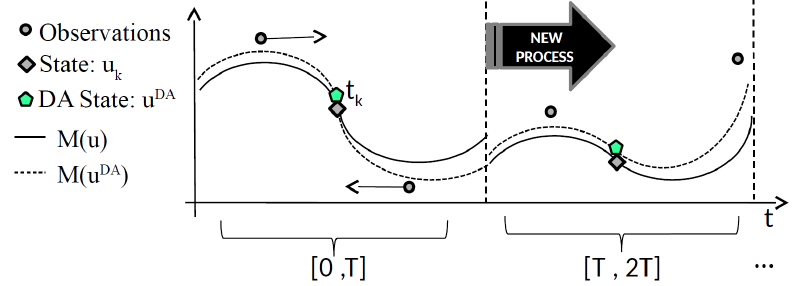
Figure 2. The Data Assimilation (DA) process.